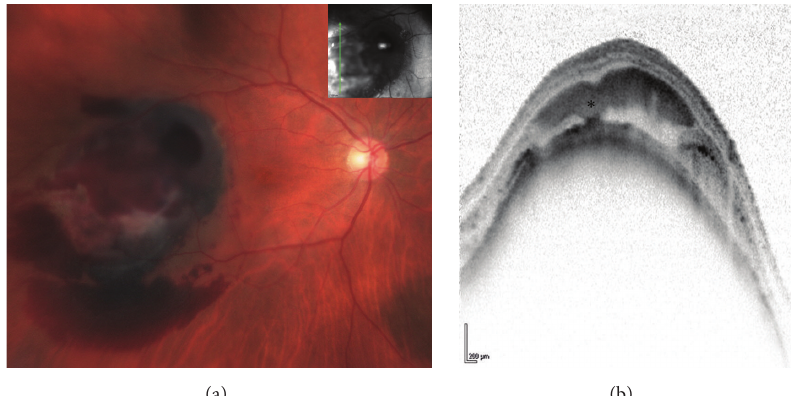
Figure 2: Right eye choroidal melanoma. The melanoma is demonstrated temporal to the macula with intra- and subretinal hemorrhage (a). Vertical OCT scan (b) at the temporal aspect of the tumor showing a smooth regular dome-shaped elevation of the choroid with subretinal hemorrhage (asterisk). There is hyperreflective thickening of the RPE causing shadowing; the RPE is not continuous on the inferior aspect of the tumor. Still, the choroidal elevation is smooth and regular.